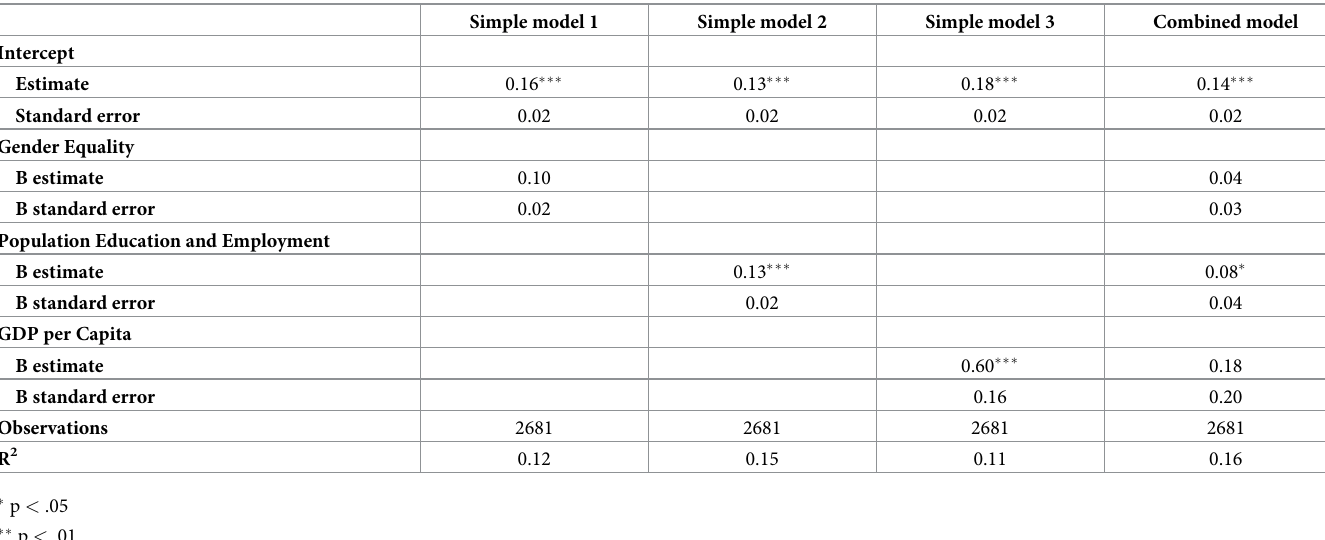
Table 1. Summary statistics of regression analyses for Verbal episodic memory task.